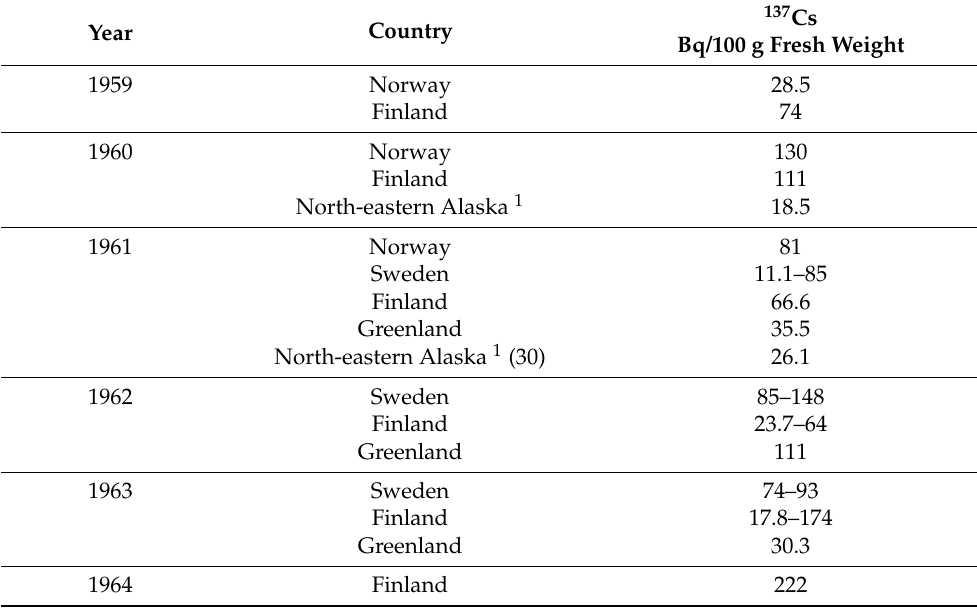
Table 1. 137 Cs contents as Bequerels (Bq/100 g) in reindeer and caribou meat in different countries